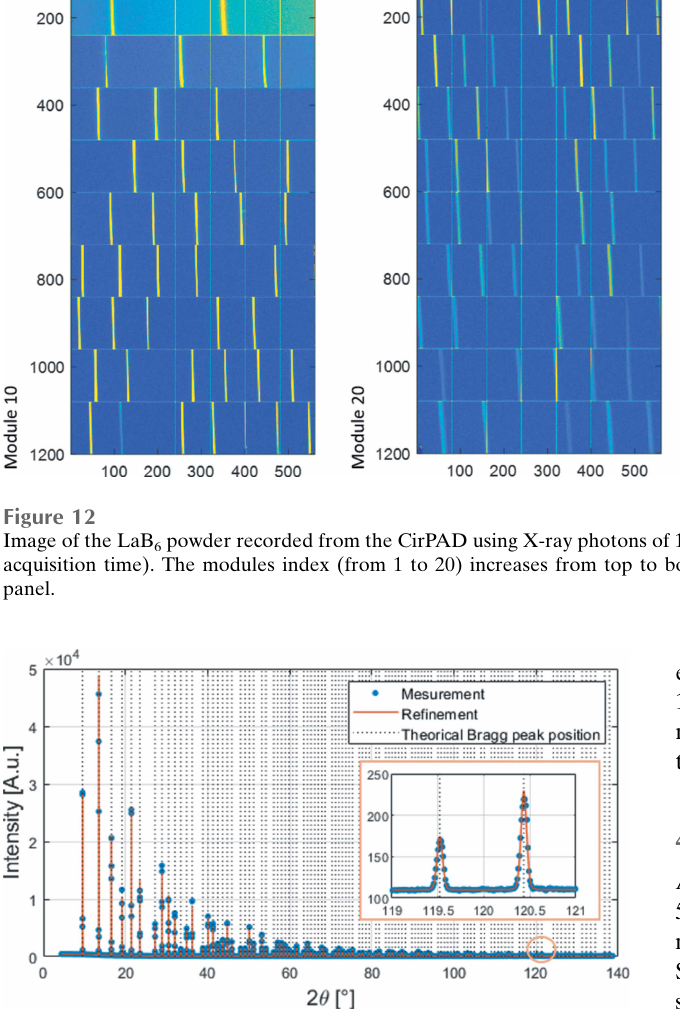
Figure 13 Powder diffraction pattern from a 0.25 mm diameter capillary filled with LaB 6 reference powder from NIST measured at 17.94 keV (blue points). Two images were recorded at two detector positions for a total acquisition time of 2 (cid:2) 10 s and the selected threshold calibration of the detector was with beam mode and SLOW settings. The red line is the whole pattern structural refinement performed using the NIST reference values. The inset shows a magnification of two peaks at high angles.